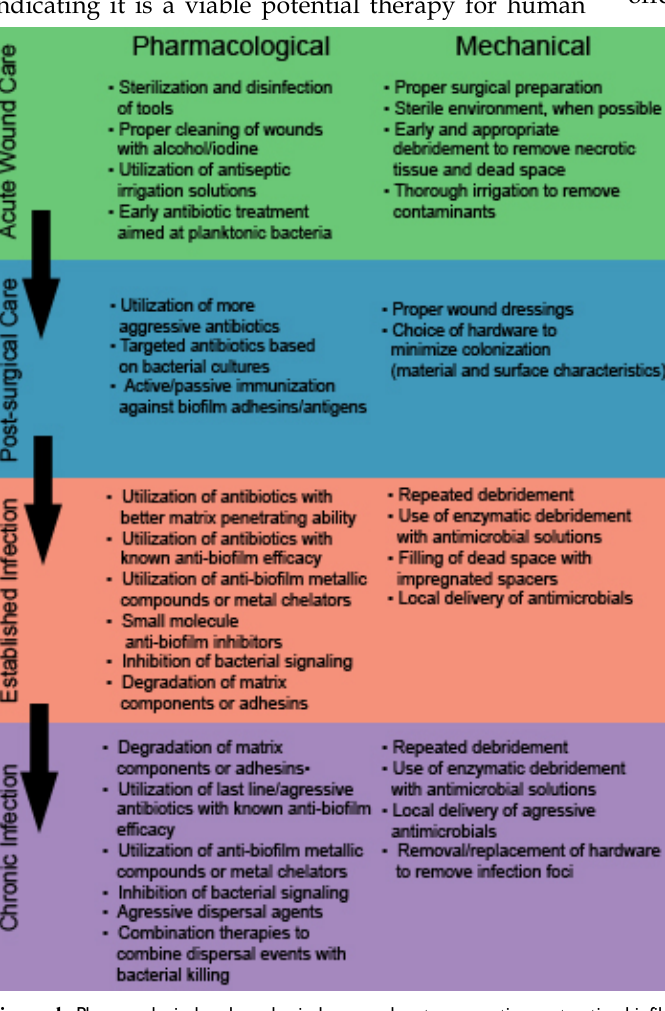
Figure 1. Pharmacological and mechanical approaches to preventing or treating biofilm based infections at various stages of wound development and care, ranging from immediately after creation of the wound (acute care) to prolonged, persistent infections (established and chronic